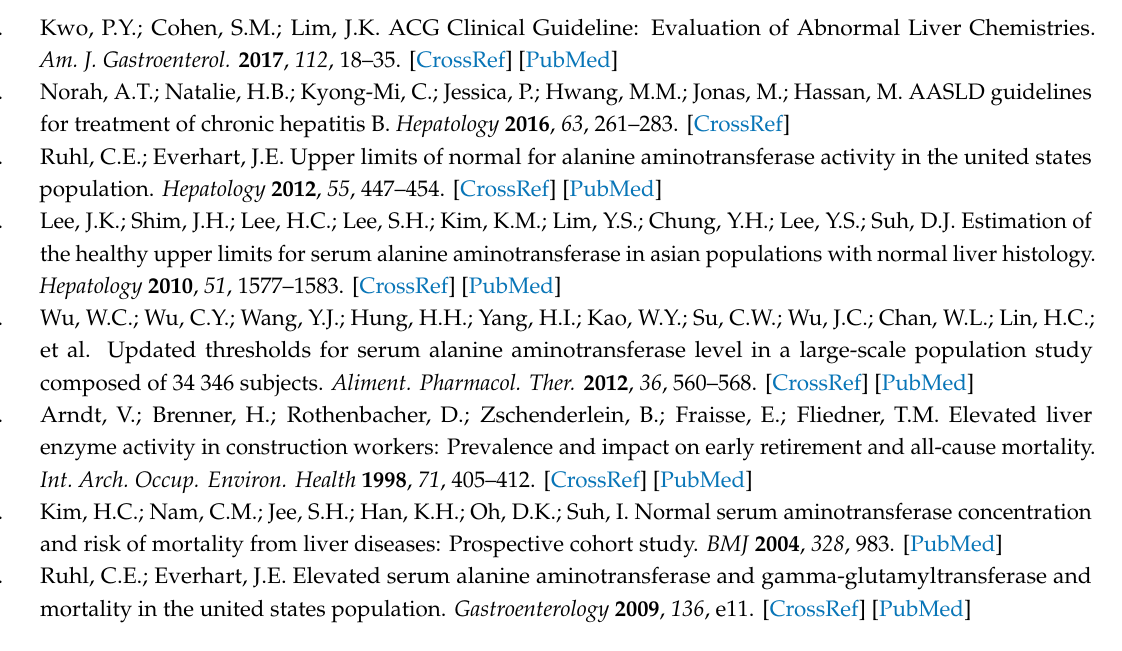
Table S1. Survival table of unfavorable liver related outcomes according to low ALT cut-o ff ; Table S2. Survival table of unfavorable liver related outcomes according to conventional ALT cut-o ff